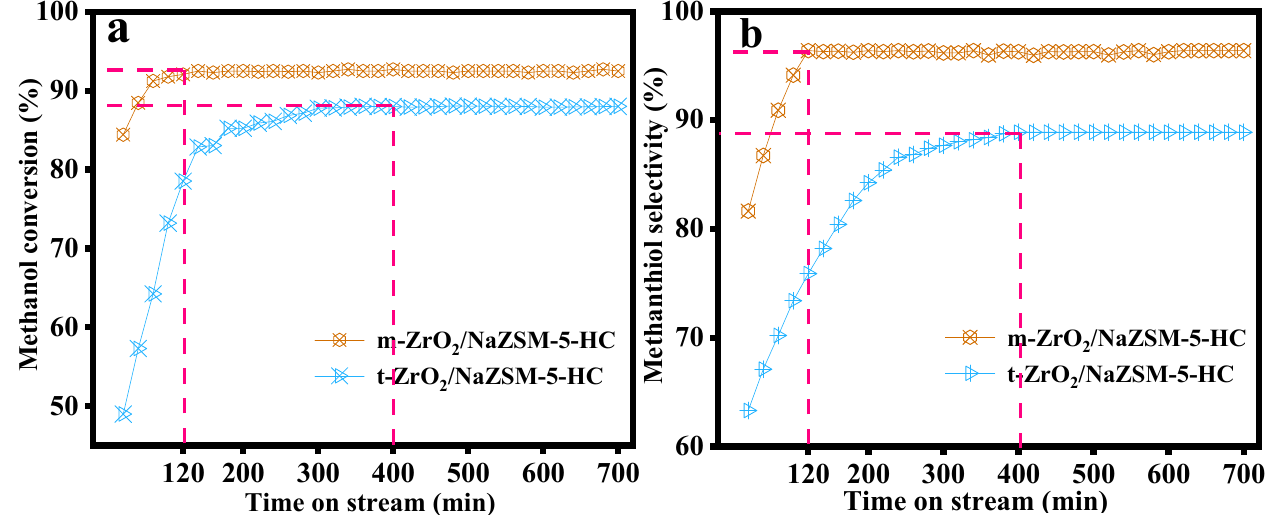
Figure 1. Catalytic performance of m-ZrO 2 /NaZSM-5-HC and t-ZrO 2 /NaZSM-5-HC composite catalysts: ( a ) methanol conversion rate and ( b ) selectivity to CH 3